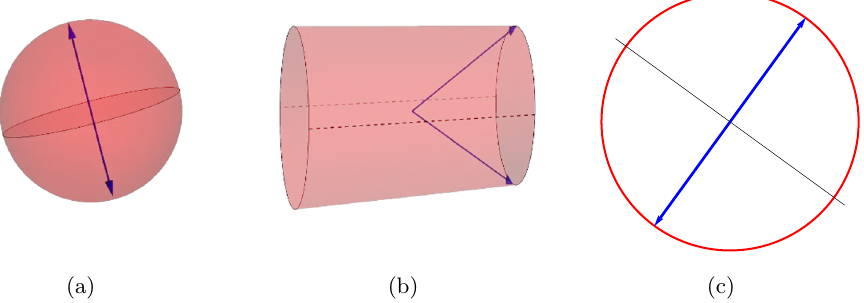
Figure 2 . Event con(cid:12)gurations that maximize event isotropy (i.e. least isotropic), assuming bal- anced (transverse) momentum. The optimal EMD transportation plan is determined by partition- ing the uniform event, where the sphere (a) is partitioned into two hemispheres, the cylinder (b) is separated along the dashed lines at (cid:12)xed (cid:30) and (cid:30) + (cid:25) , and the ring (c) is divided in